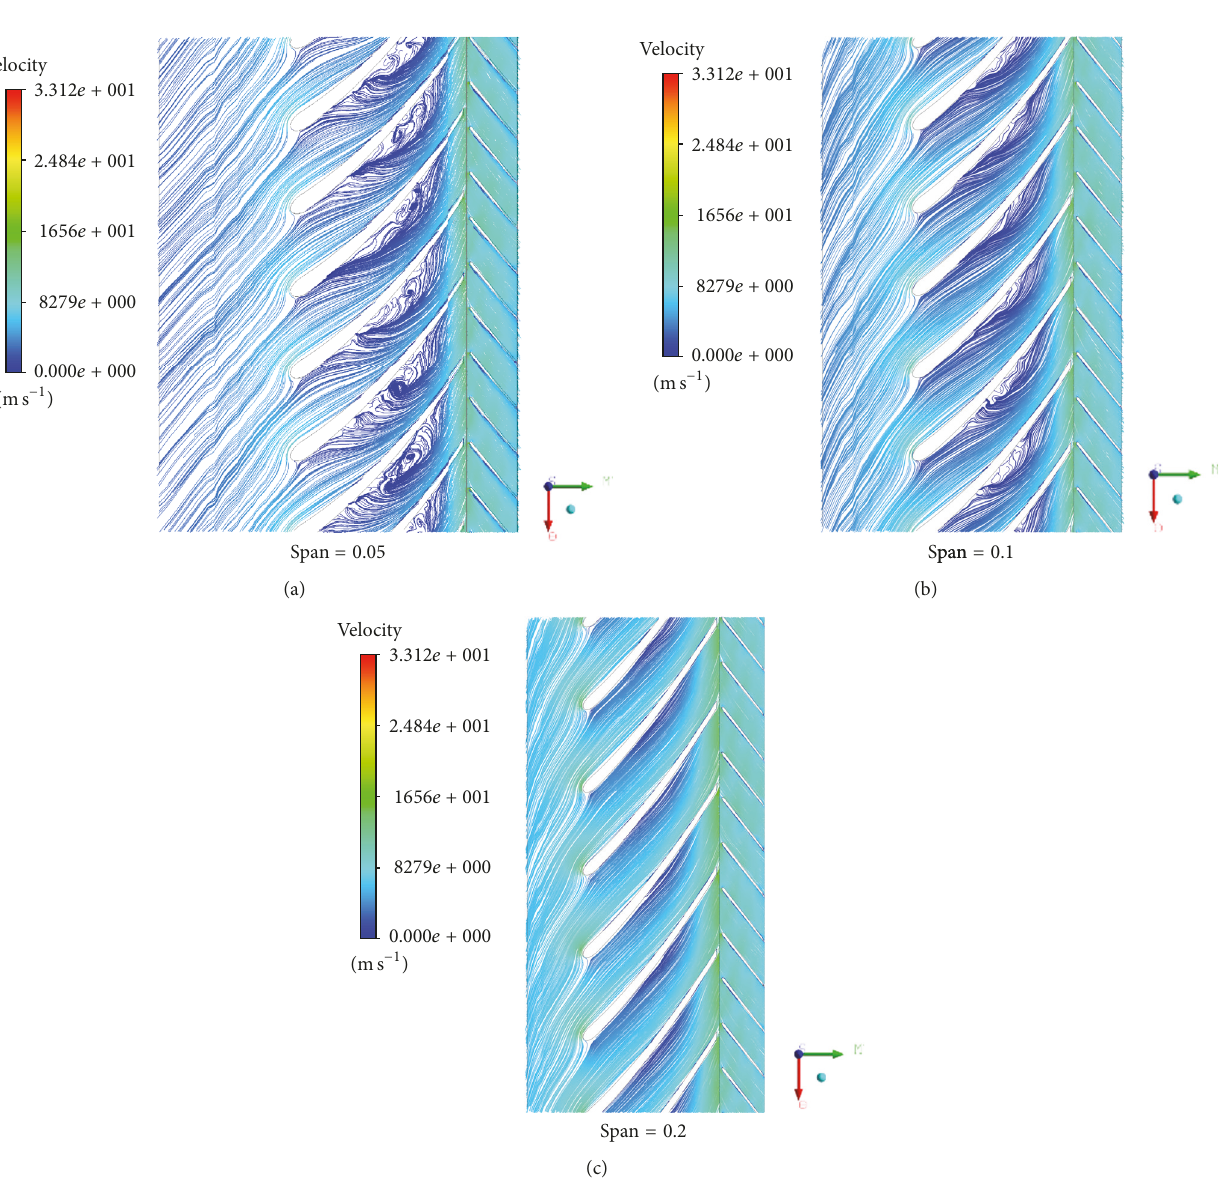
Figure 15: Backflow or vortex shedding at different